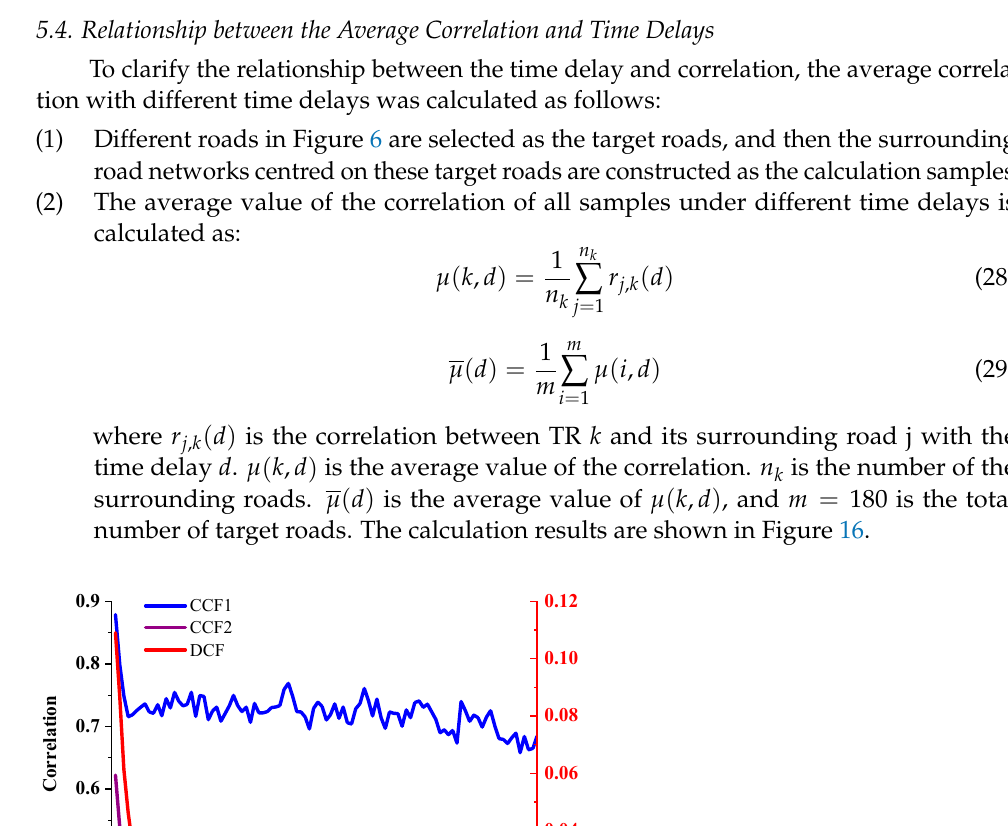
Figure 15. Calculation results for roads 4 and 6.